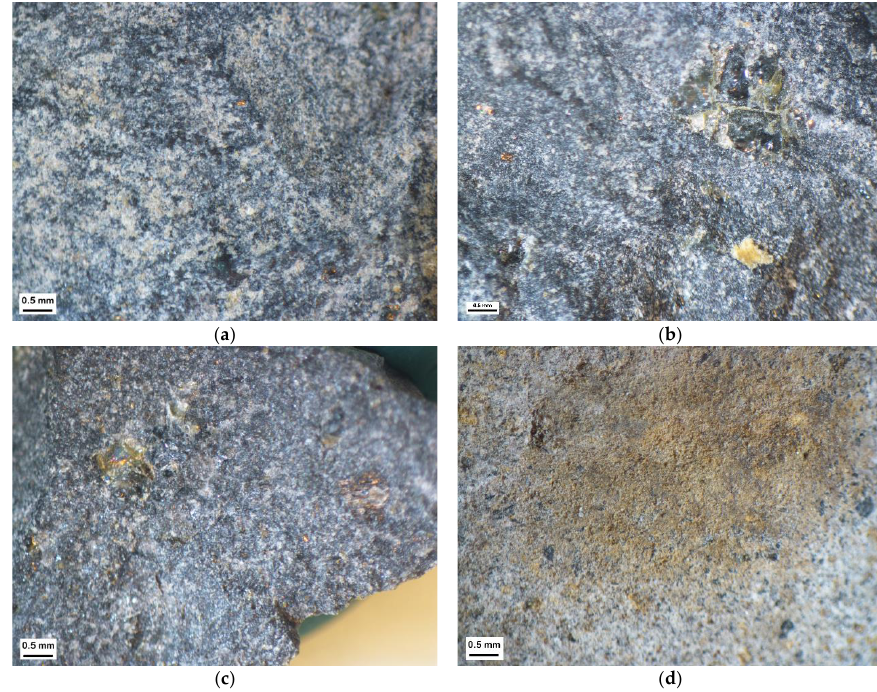
Figure A11. Characteristics of cracks in samples after crushing in cone crusher (feed — non-flaky grains): ( a ) Basalt aggregate 1, non-flaky grains, +8 mm; ( b ) Basalt aggregate 1, non-flaky grains, +16 mm; ( c ) Basalt aggregate 1, flaky grains, +8 mm; ( d ) Basalt aggregate 1, flaky grains, +16 mm.